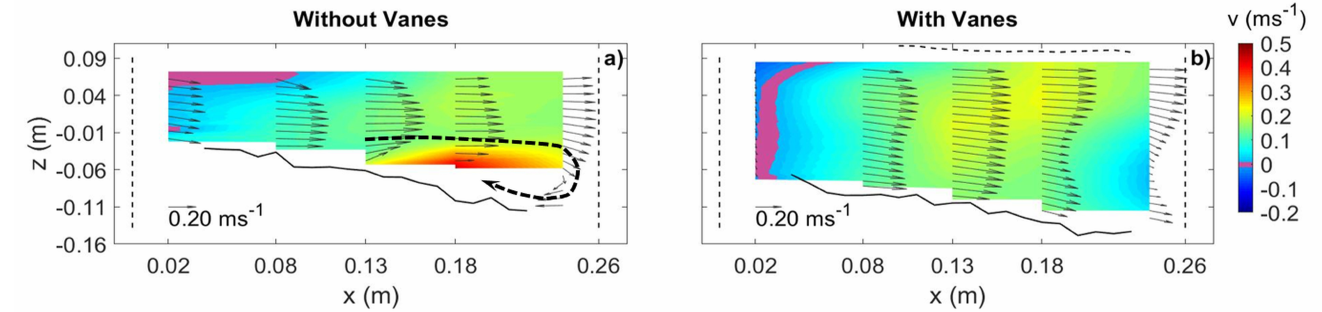
Figure 11. Velocity v (ms − 1 ) as color scale and direction and magnitude of the velocity components ( u , w ) (ms − 1 ) as vector arrows, in the NV and the VF experiments, at: ( a ) y = 0.67 m. ( b ) y = 0.67 m.